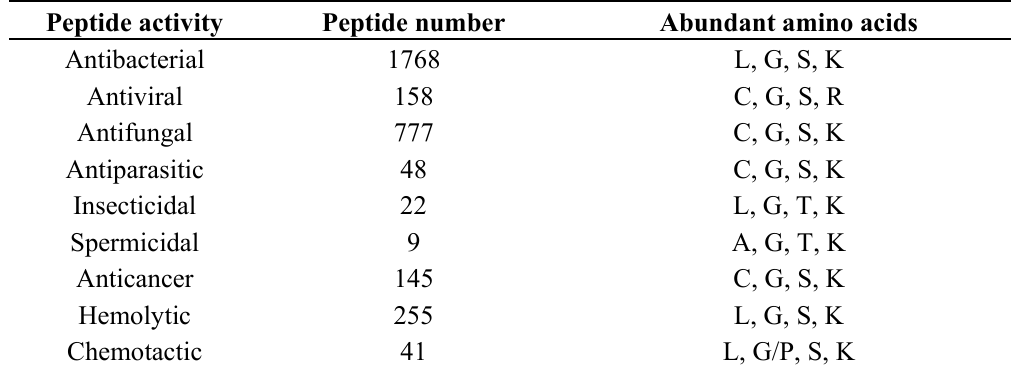
Table 1. The number and abundant amino acids of antimicrobial peptides with defined biological activity 1